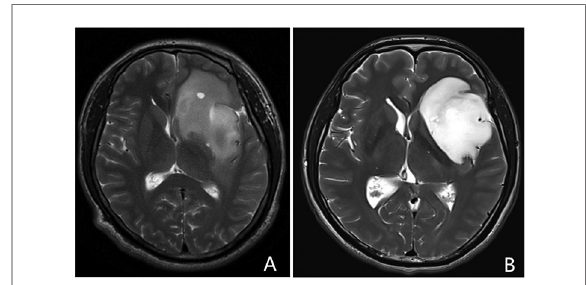
FIGURE 3 Representative images of the fl at inner edge sign of insular gliomas based on the preoperative MRI. ( A ) Insular glioma with an obscure inner edge sign. ( B ) Insular glioma with a fl at inner sign. MRI, magnetic resonance